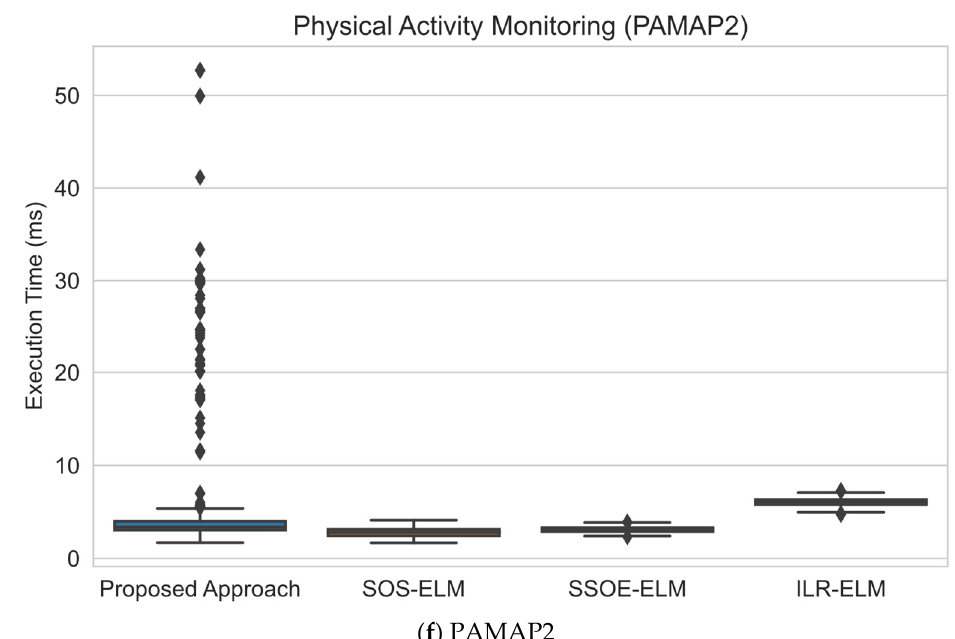
Figure 7. Execution time distribution comparison among approaches in milliseconds (ms): ( a ) on sensorless drive data set, this approach required less time to update the model compared to ILR-ELM but had many outliers to remove the noise; ( b ) this approach required less time than ILR-ELM to update the model on the magic gamma data set but also had outliers in execution time; ( c ) on the HAR data set, the execution time required was also less than only ILR-ELM’s but its mass was mostly located towards a lower execution time (right skewed); ( d ) on the crop mapping data set, this approach took the longest time to update but its execution time was mostly towards a lower execution time (right skewed); ( e ) on the KDDCup 1999 data set, this approach took less time on average than ILR-ELM to update the model but it also had many outliers in execution time; ( f ) on PAMAP2 data set, despite having an execution time comparable to other approaches with less execution time, this approach also had many outliers in the execution time.